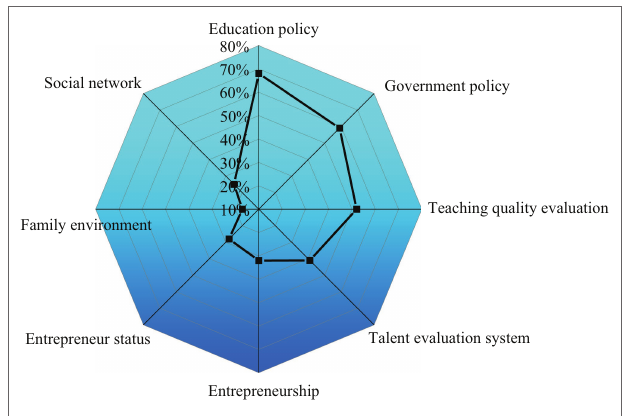
FIGURE 8 | Innovation and entrepreneurship quality of college